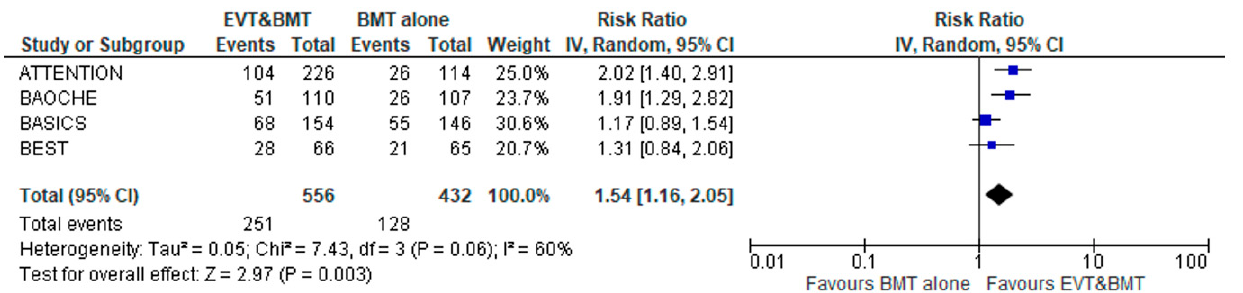
Figure 2. Forest plot presenting the association of endovascular treatment (EVT) combined with best medical treatment (BMT) compared to BMT alone with good functional outcomes (mRS 0–3) at 3 months among acute basilar artery occlusion patients.